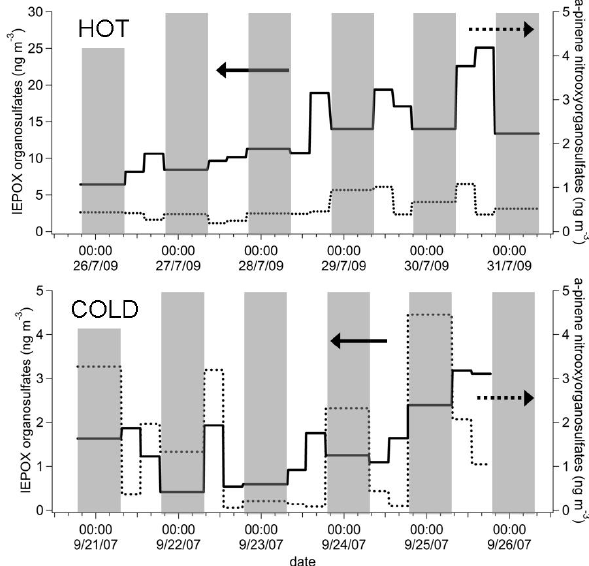
Fig. 8. Time series of the most dominant biogenic organosulfate compounds, IEPOX organosulfates (solid black lines), methacrolein (MACR) organosulfate (dashed black lines) and α -pinene nitroxy- organosulfates (dotted gray lines), observed during a 5day period of high volume filter collections. Shaded bars indicate